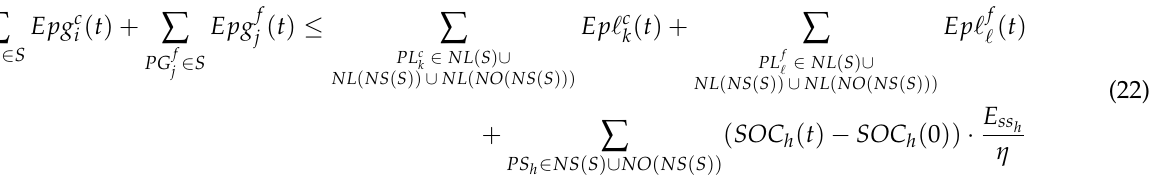
Figure 9. Power generators subset S and neighboring power devices. However, the set of power loads in NL ( S ) and set of power storage devices in NS ( S ) may receive power from other power generators outside S . Similarly, NO ( NS ( S )) can receive power from power generator outside S and from storage devices outside NS ( S ) , the set of power loads in NL ( NS ( S )) and NL ( NO ( NS ( S ))) can also receive power from other power storage devices not in NS ( S ) and NO ( NS ( S )) . Therefore, the total sum of power consumption consumed by power loads in NL ( S ) ∪ NL ( NS ( S )) ∪ NL ( NO ( NS ( S ))) and the increase of energy in storage devices in NS ( S ) ∪ NO ( NS ( S )) is no smaller than the total generated power by power generators in S . From this point of view, we can conclude